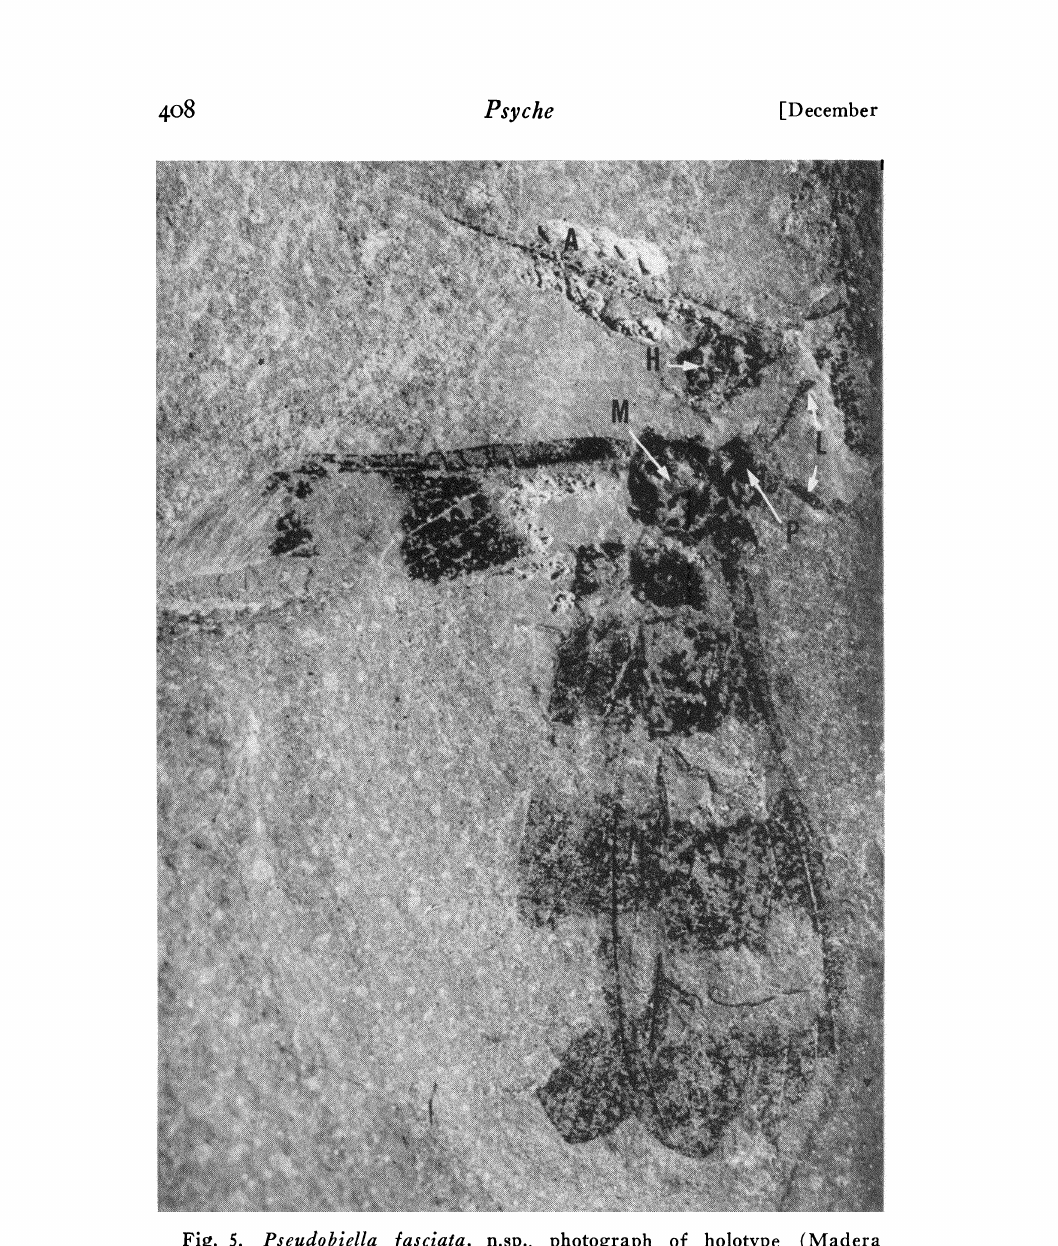
Fig. 5. Pseudobiella [asciata, n.sp., photograph of holotype (Madera Formation, New Mexico). A, antenna; H, head; 19, prothorax; M, meso- thorax; L prothoracie